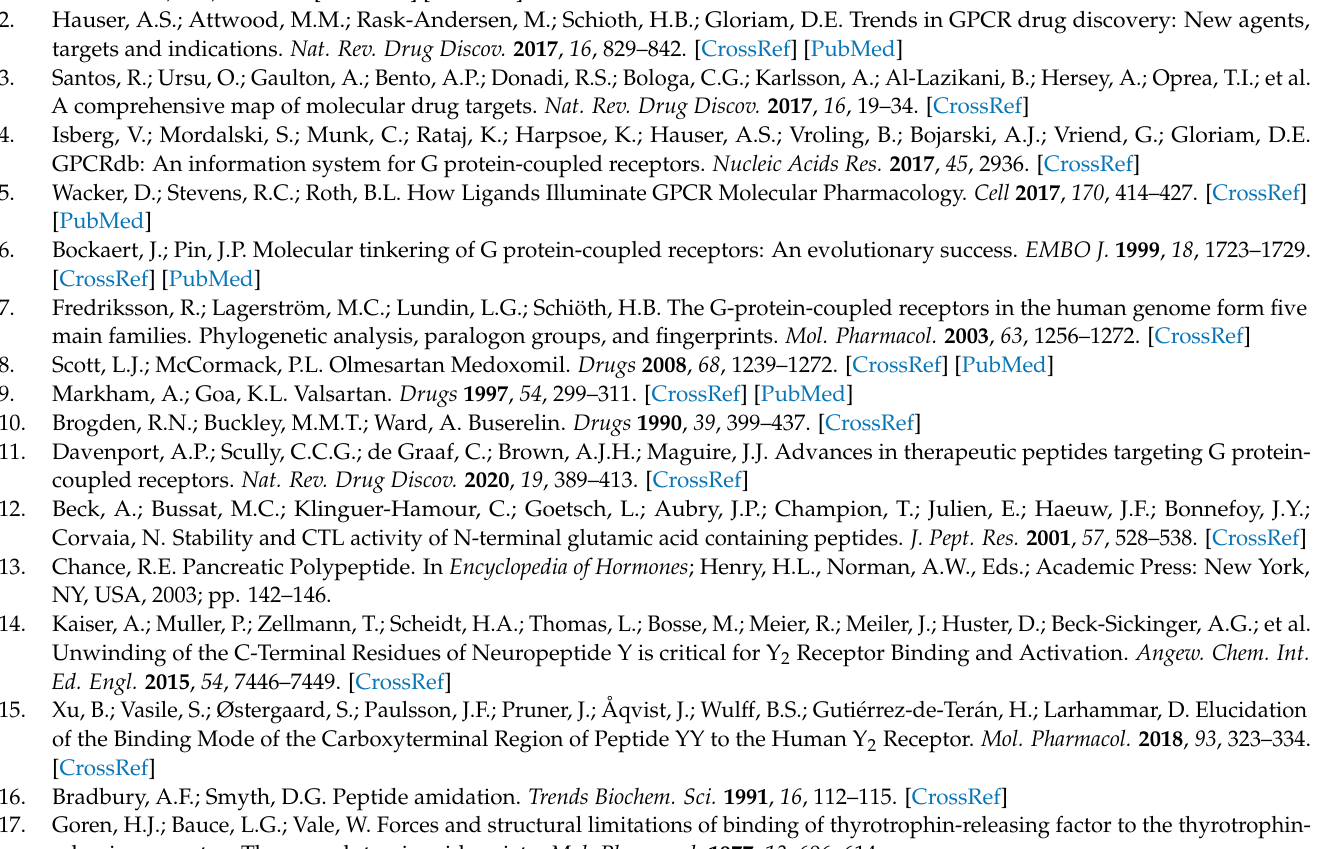
Figure S3: Comparison between the PMX53 structures in the Rosetta relaxed model (pink) and in the crystal structure (PDB ID: 6C1Q) (cyan). While the sidechain of ornithine (ORN) at position 2 and the carboxylate group of ARG at position 6 are linked in the crystal structures, they form a salt bridge in the Rosetta relaxed